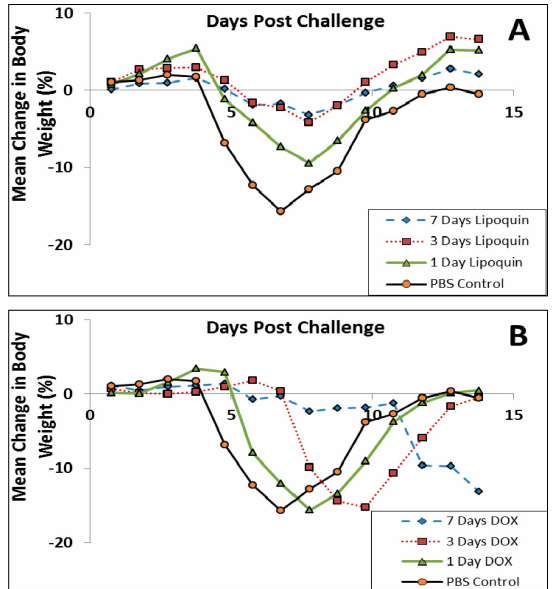
Figure 12. Efficacy of ( A ) intranasal Lipoquin or ( B ) oral doxycycline (DOX) against C. burnetii versus PBS-treated control mice. Mean percentage change in body weight of mice ( n = 10) infected with C. burnetii and treated for 1 day, 3 days, or 7 days post-challenge. Reprinted with permission from [52]. Copyright 2014 American Society for